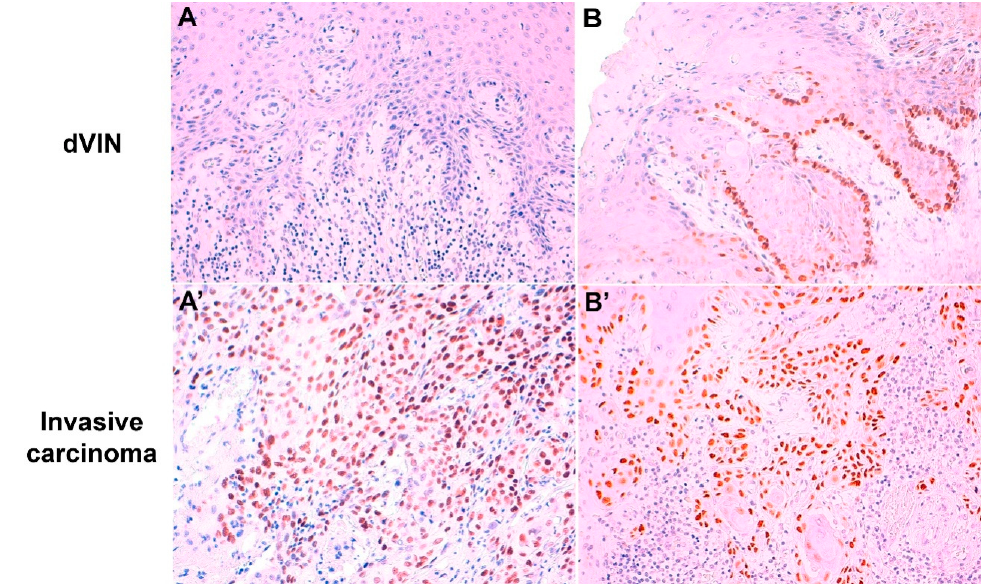
Figure 3. Two cases with discordant p53 immunohistochemical patterns between intraepithelial lesion and adjacent invasive carcinoma. ( A ): Differentiated vulvar intraepithelial neoplasia (dVIN) showing wild-type scattered p53 pattern; ( A’ ) invasive carcinoma from the same case with p53 parabasal overexpression; ( B ): dVIN with p53 basal staining; ( B’ ) invasive component from the same case showing p53 parabasal overexpression (p53 IHC immunostaining with hematoxylin counterstain, original magnification: 100× ( A , B , B’ ) and 200× ( A’ )).